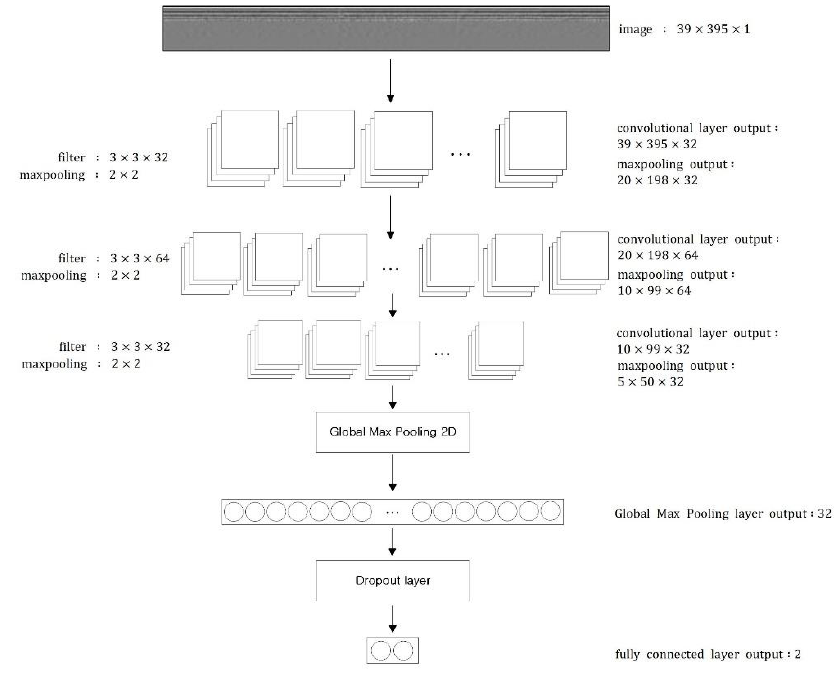
Figure 9. The proposed CNN model structure.